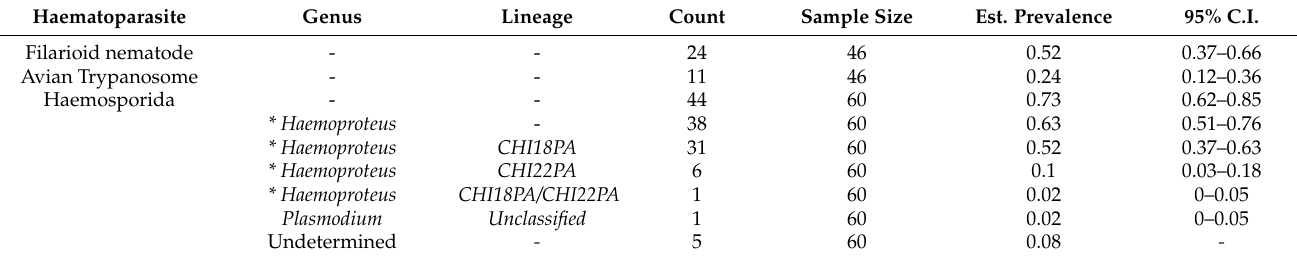
Table 1. Haematoparasite prevalence in great-tailed grackles ( Quiscalus mexicanus ), College Station, Texas, 2015.